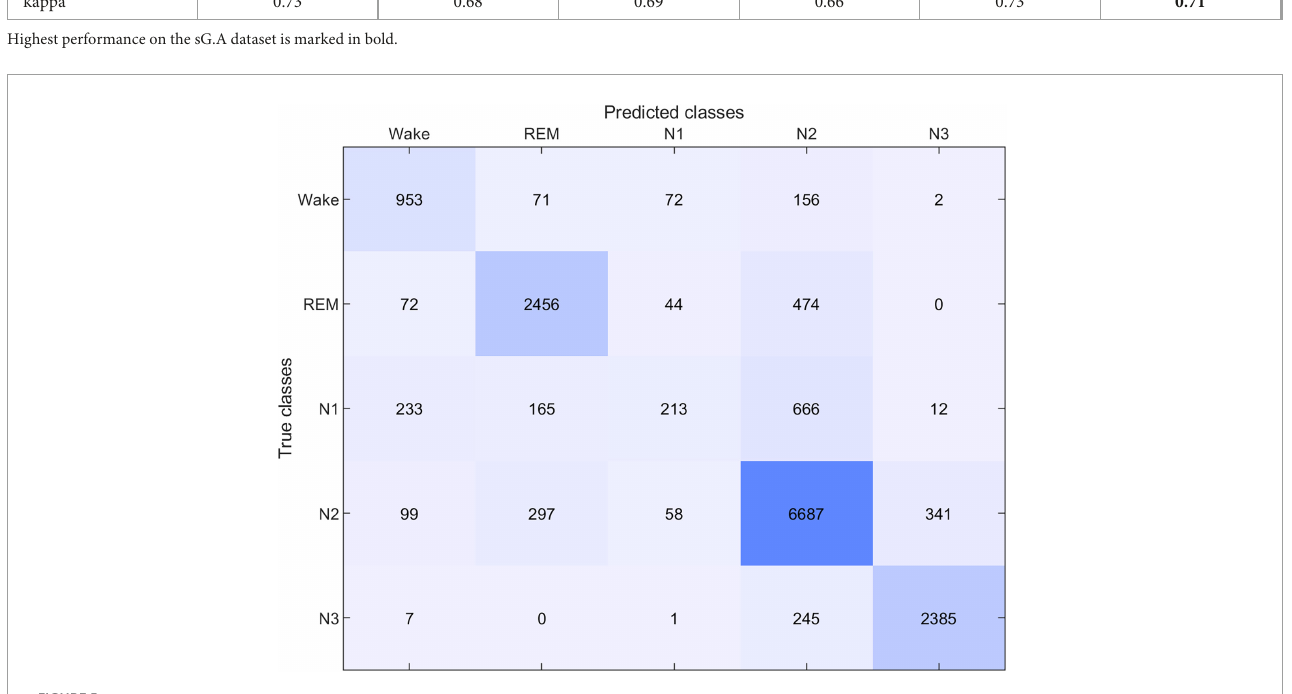
FIGURE5 Confusion matrix for sleep scoring with the sCGsG cross-validation